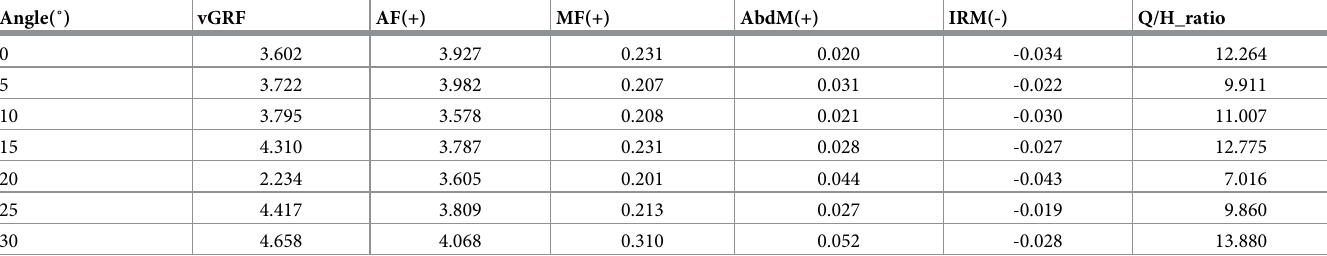
Table 3. Vertical GRF, knee JRF and JRM and Q/H force ratio at peak vGRF time instance for various hip internal rotation angles.